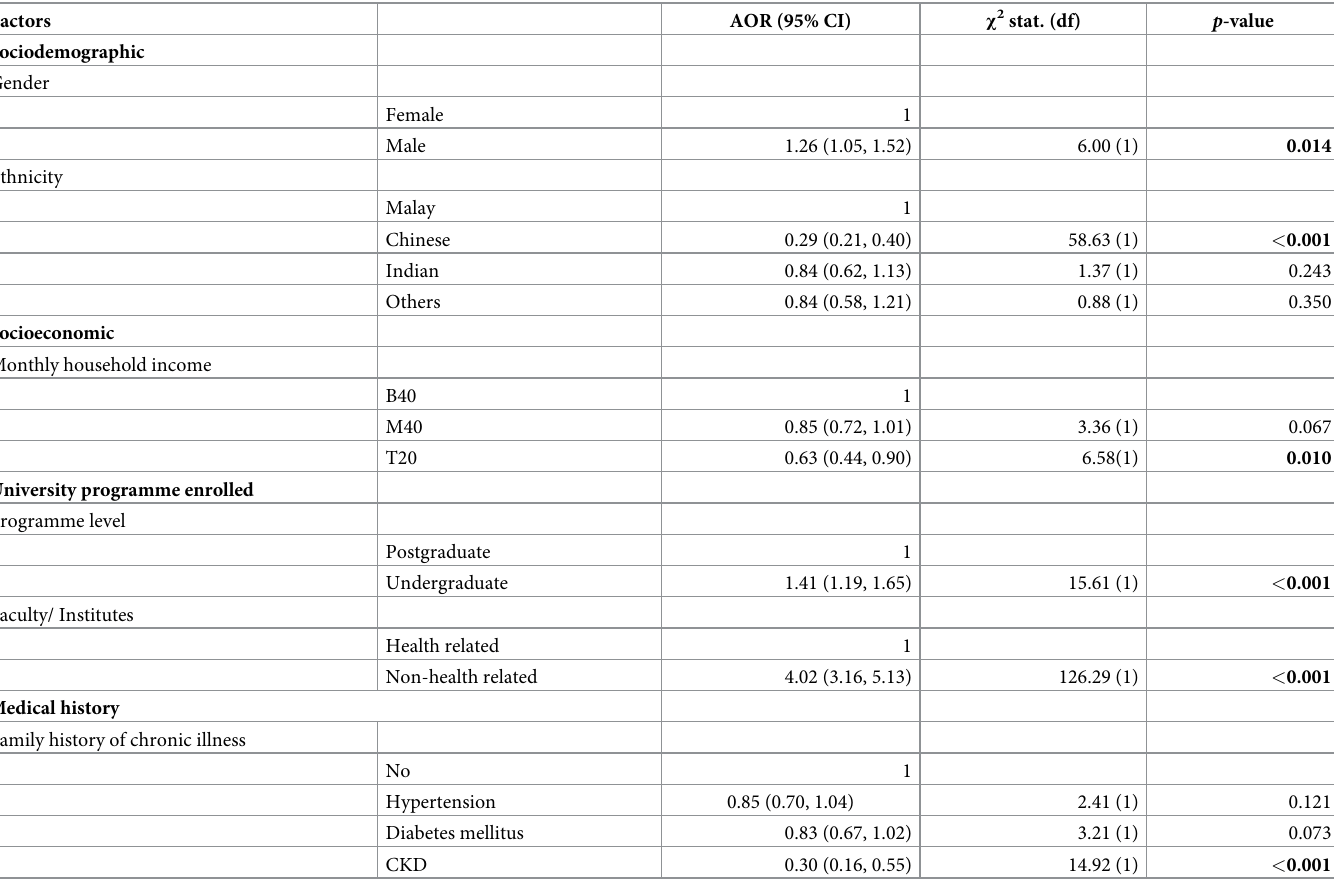
Table 3. Final factors associated with below average CKD knowledge among students of a public university in Klang Valley, Malaysia.